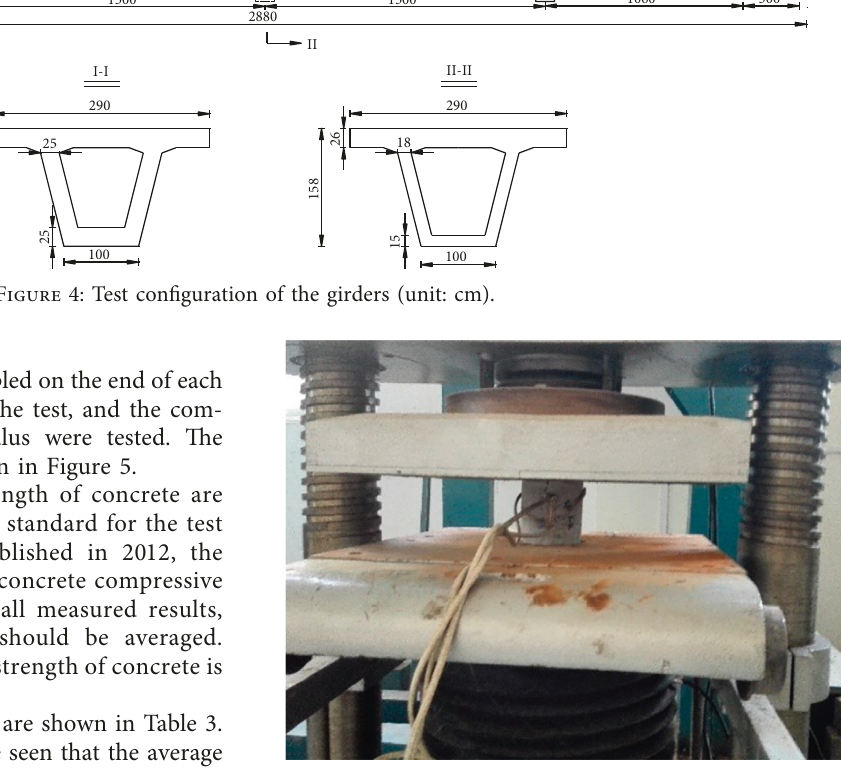
Figure 5: Compressive test of the